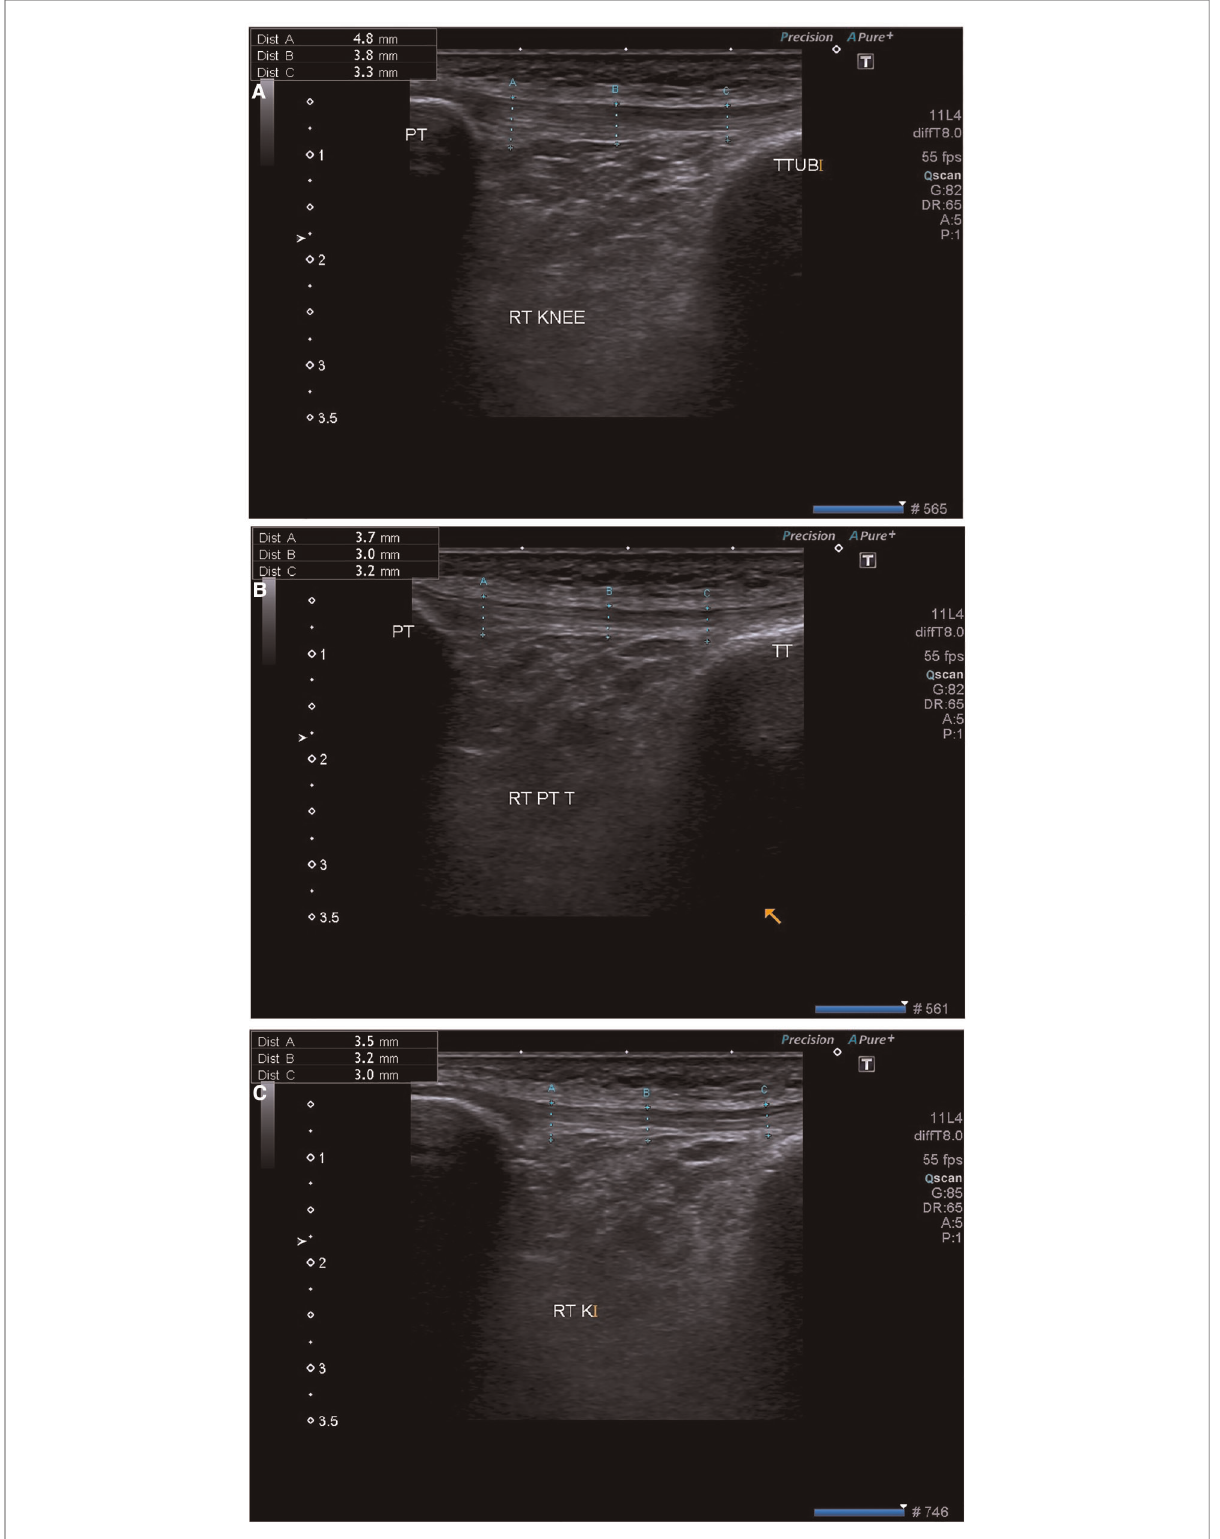
FIGURE 2 Ultrasonographic images from a 27-year-old Male with patellar tendinosis and VAS scores of 6 (pre-procedure), after ( A ) 1st week ( B ) 2nd week and ( C ) 4th week in the same patient. The post-intervention sonographic image con fi rms decreased tendon thickness and the hypoechoic segment resolved in the patellar tendon VAS score of 3 (post-procedure). VAS, visual analog